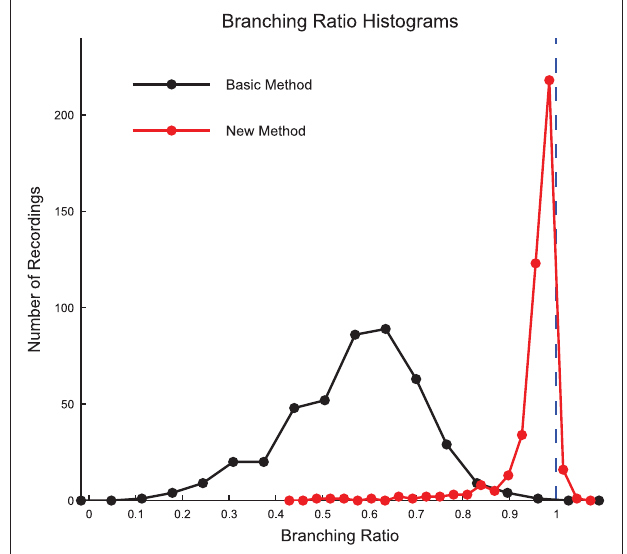
FIGURE 9 | Culture data branching ratios were near 1 after sub-sampling correction. The branching ratios of the culture recordings were found to be close to 1 after correcting for sub-sampling using the new method established by Wilting and Priesemann (2016) (Equation 13), with most data sets being slightly sub-critical. The basic branching ratio calculation method (Equation 11) produced branching ratios that were more widely varied and strongly sub-critical. Histogram bin sizes optimized using methods established in Terrell and Scott (1985).